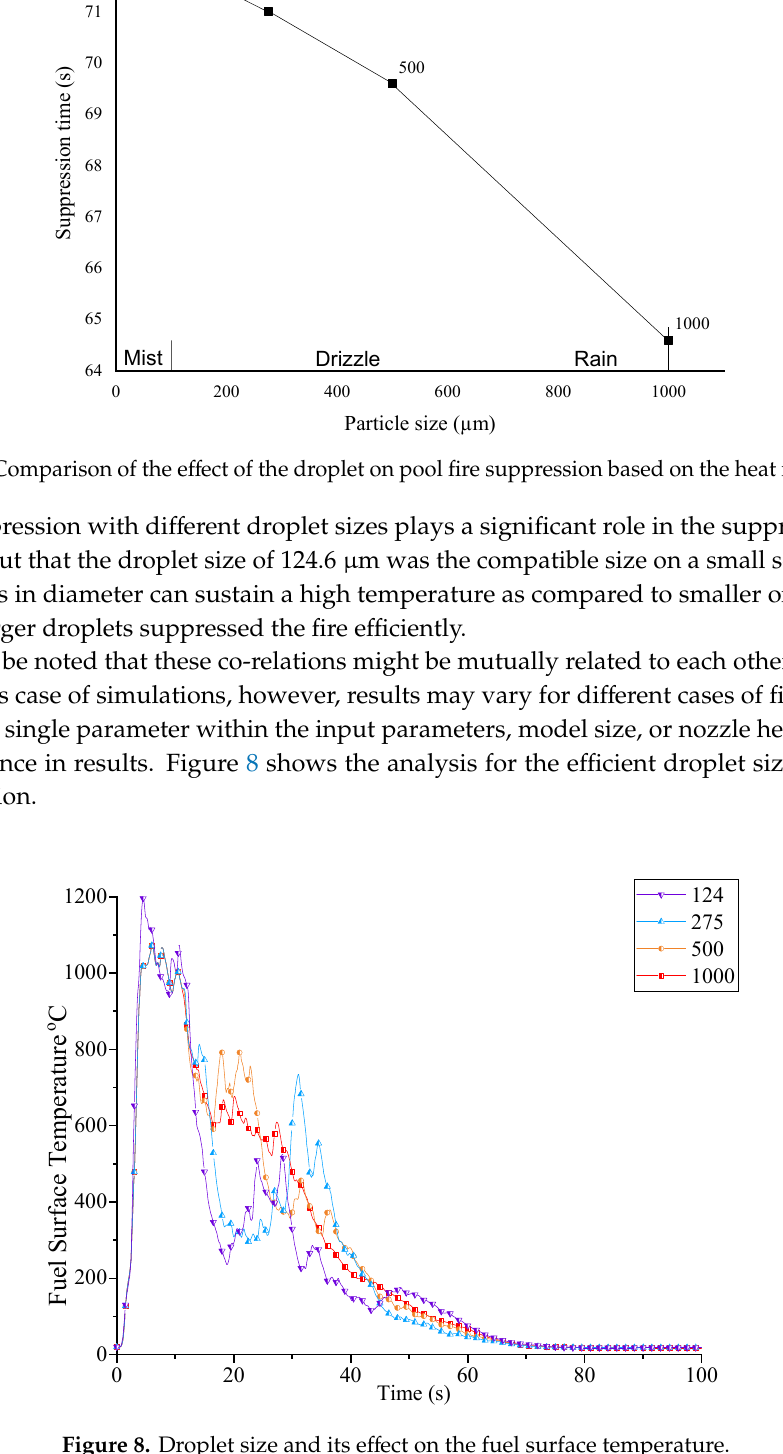
Figure 8. Droplet size and its effect on the fuel surface temperature.